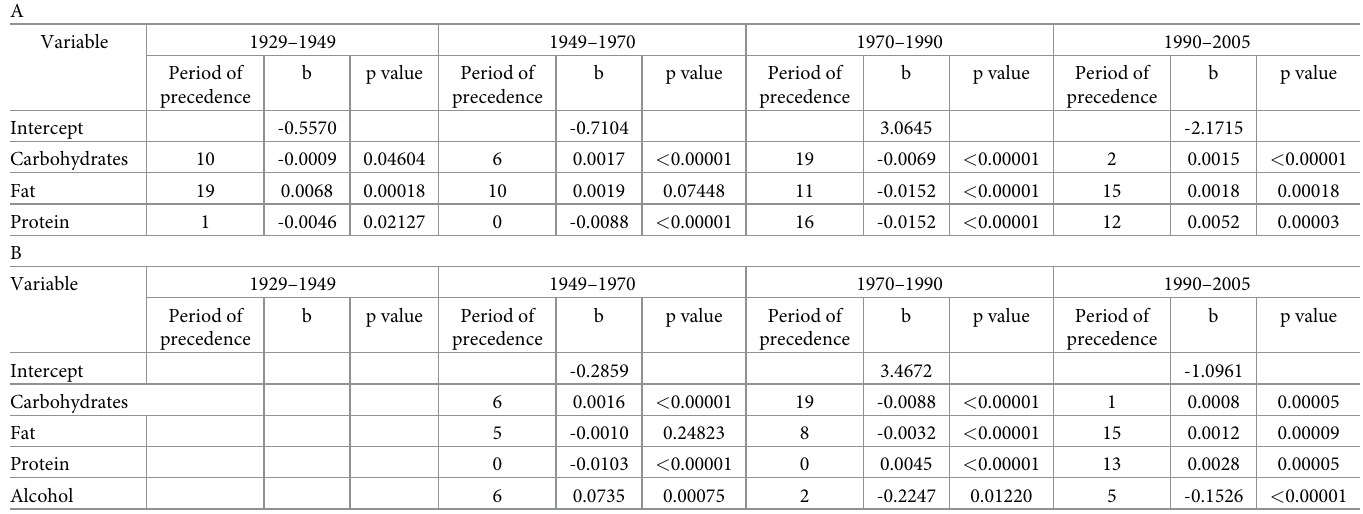
Fig 1. ABCD The time course of the availability of four macronutrients and variability of R in the period 1929–2005. A Fat total, B Carbohydrates, C Protein, D Alcohol total. https://doi.org/10.1371/journal.pone.0209723.g001 Table 1. Regression coefficients for three macronutrients without alcohol (A) and three macronutrients with alcohol (B) and their corresponding periods of prece- dence in